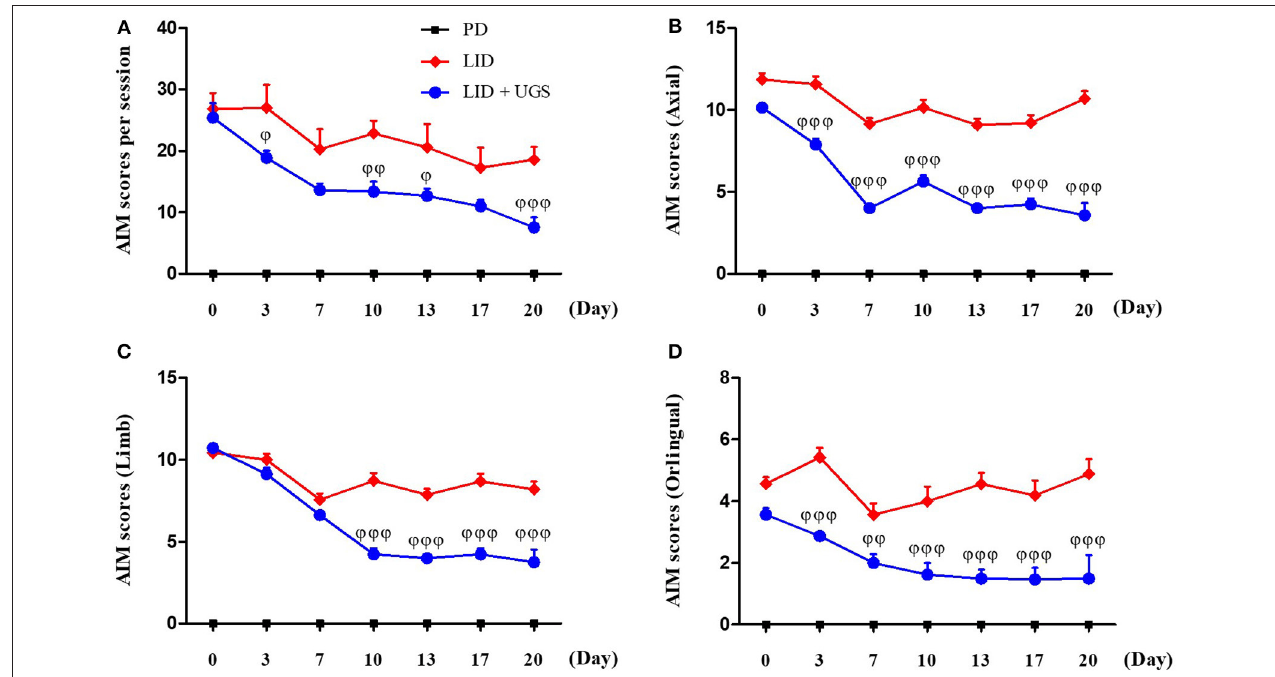
FIGURE 5 | UGS suppressed the dyskinetic movements in LID mice . 6-OHDA-lesioned mice treated with UGS ameliorates LID over the 21 days treatment period, which differed significantly from the LID groups in all testing sessions. The sum of axial, limb, and oroligual (A) , axial (B) , forelimb (C) , and oroligual (D) AIMs on each testing session were rated following the administration of UGS. Values are given as the mean ± S.E.M. ( N = 6). The significance of differences was analyzed by repeated measures of ANOVA with Bonferroni’s post hoc tests: φ p < 0.05, φφ p < 0.01, and φφφ p < 0.001; mean values were significantly different from the LID